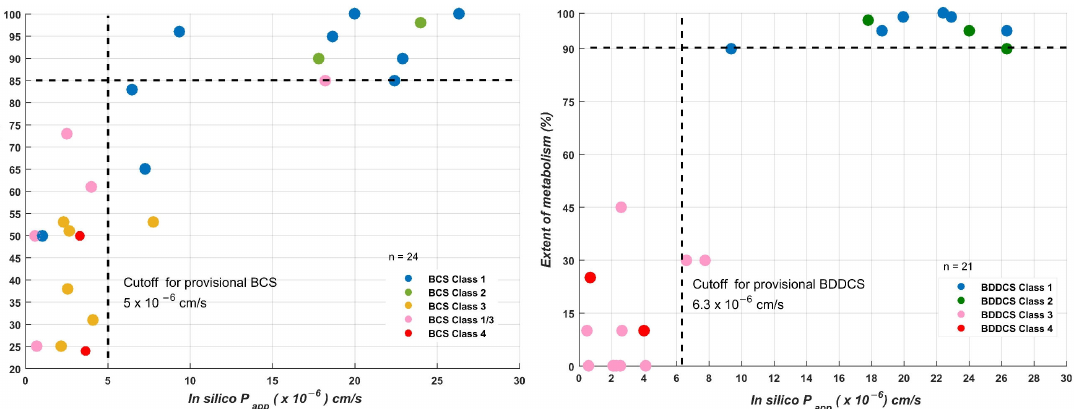
Figure 5. Relationship between in silico apparent permeability coefficients and fraction absorbed for the 32 reference drugs of the International Council Harmonization (ICH) list. Data points are classified according to BDDCS classes 1–4 or BCS 1–4.